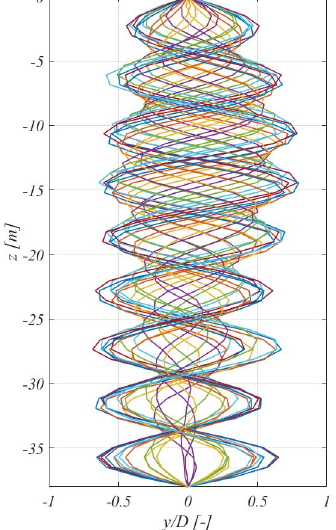
Figure 22. VIV snapshot of riser in time history.